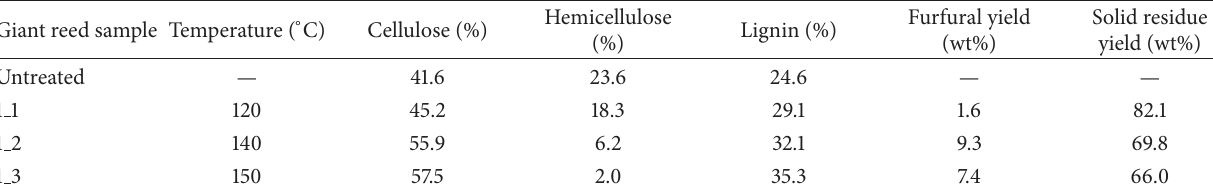
Table 4: Ternary mixtures compositional data of a raw giant reed sample (stem + leaf) and of its solid residues coming from the hydrolysis reaction, by adopting different reaction temperatures. Reagents and operating conditions: 0.35 g of biomass, 0.10mL of HCl 37 wt%, and 5.0 g of water. Ramping time = 5 min. All tests were performed in a CEM Discover S-Class MW reactor. Furfural yield is calculated as furfural Yield (wt%) = [furfural recovered after hydrolysis reaction (g)/dried starting biomass (g)] × 100. Solid residue yield is calculated as solid residue yield (wt%) = [solid recovered after hydrolysis reaction (g)/dried starting biomass (g)] ×